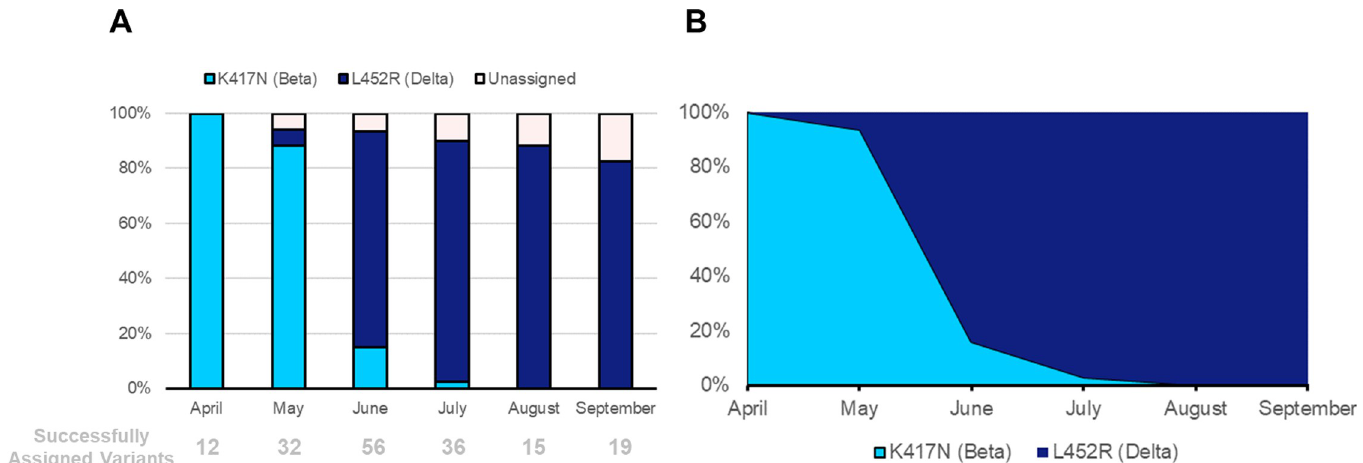
Fig 5. Variant distribution for Limpopo specimens sampled between April and September 2021. Graphs show the rapid displacement of the Beta (cyan) variant by the Delta (dark blue) variant. (A) Variant distribution for all samples analyzed and (B) Distribution of only the samples that were successfully assigned a variant.